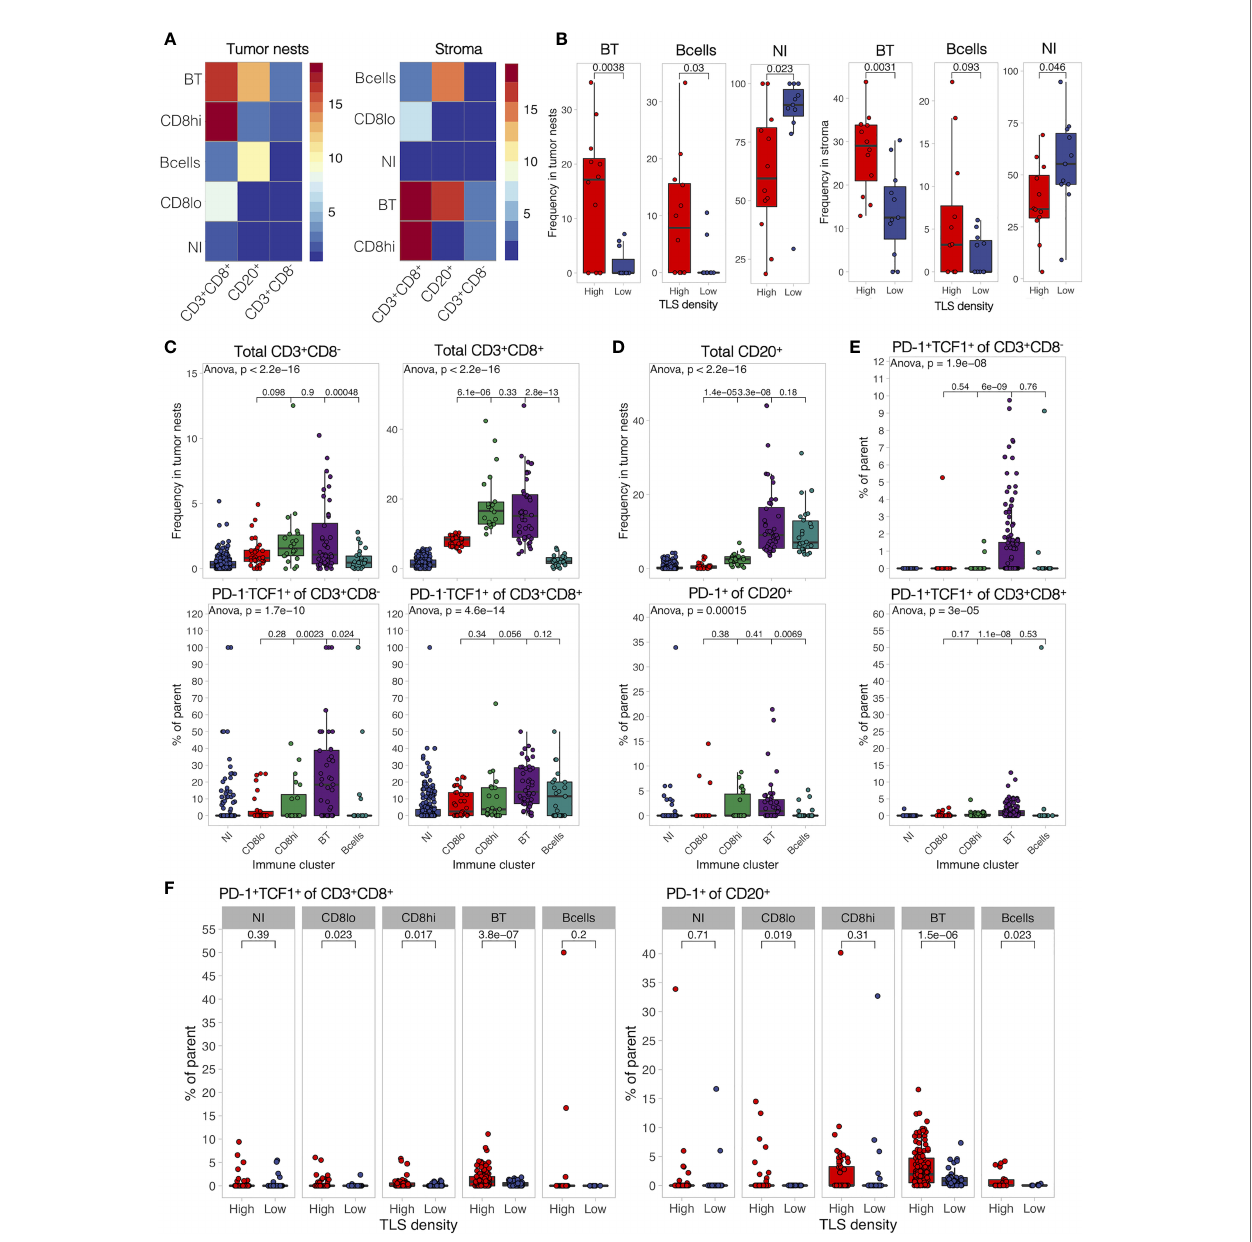
FIGURE 6 | B- and T-cell co-in fi ltration is common in TLS-high tumors and shows differential immune composition. (A) Tumor and stromal regions were classi fi ed based on their composition of B cells, CD8 - , and CD8 + T cells by hierarchical clustering. Five immune clusters were identi fi ed in both regions: (1) B- and T-cell co- in fi ltrated (BT, both populations with frequency >5%), (2) B cell-dominant (B cells, B cells >5%, and CD8 + T cells <5%), (3) CD8 + T cell-dominant high frequency (CD8hi, >10% of cells are CD8 + T cells, B cells <5%), (4) CD8 + T cell-dominant low frequency (CD8lo, >5% < 10% of cells are CD8 + T cells, B cells <5%), and (5) non-in fi ltrated (NI) (B cells and CD8 + T cells both <5%). Heatmaps display the average frequency of the measured cell populations in the identi fi ed immune clusters. (B) Frequency of each identi fi ed immune cluster was determined as the proportion out of all analyzed tumor and stromal segments in each patient. Immune cluster frequencies were compared between TLS-high and TLS-low patients. (C) Frequency of in fi ltrating total CD8 - and CD8 + T cells (top panels) as well as their proportion of PD-1 - TCF1 + naïve cells (bottom panels) was measured in each individual tissue segment (image) and compared in different tumor immune clusters. (D) Frequency of in fi ltrating total CD20 + B cells (top panels) as well as their proportion of PD-1 + activated cells (bottom panels) was measured in each individual tissue segment (image) and compared in different stromal immune clusters. (E) Proportion of PD-1 + TCF1 + progenitor-like cells from total CD8 - (top) and CD8 + (bottom) T cells was measured in each tissue category per image and compared in different stromal immune clusters. (F) Proportion of PD-1 + TCF1 + progenitor-like CD8 + T cells and PD- 1 + B cells was measured in each individual tissue segment (image) and compared between different TLS density groups for each stromal immune cluster separately. In all panels, two groups (as indicated by group connectors below p -values) were compared by two-tailed t -test without correction for multiple testing. More than two groups were compared by one-way